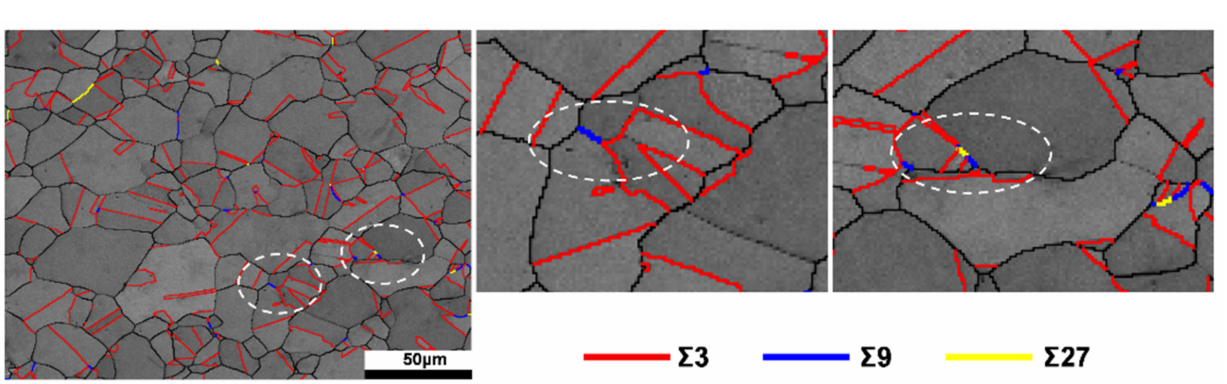
Figure 15. The twin grain boundaries of Σ 3, Σ 9, and Σ